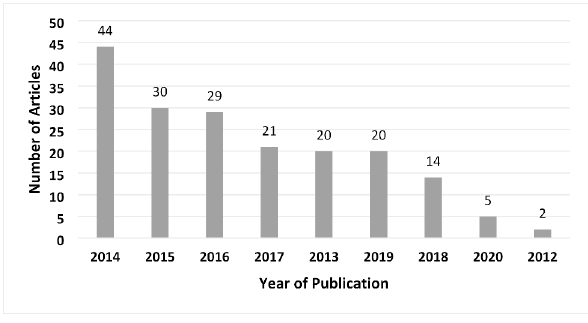
Fig. 2 Number of Articles Analyzed by Year of Publication (n = 185)